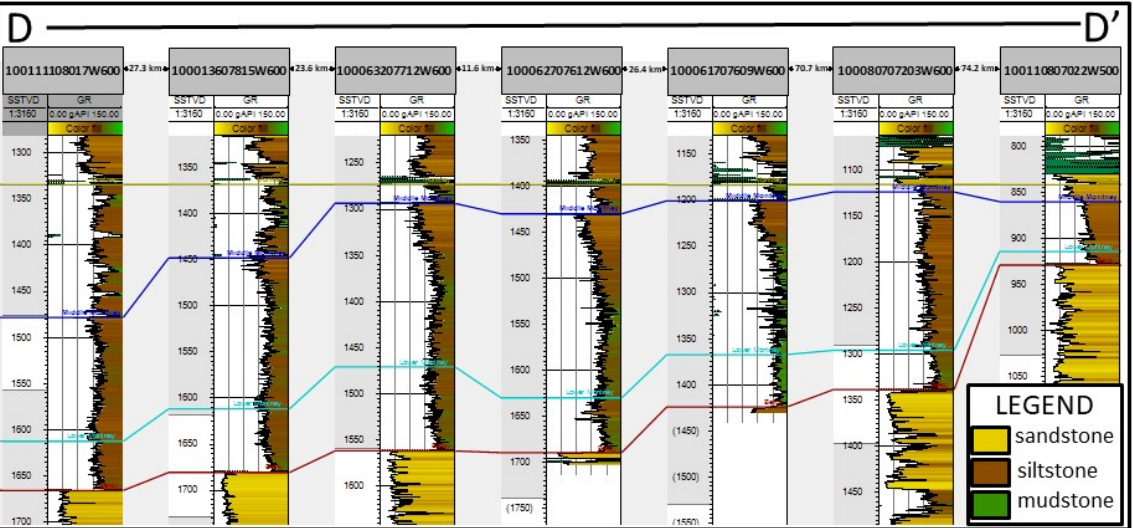
Figure 31. NW-SE cross-section along the depositional strike near the Dawson Creek area. See Figure 24 for the location of the cross-section D–D ′ . The Upper Montney is more organic rich and/or clay rich than the Middle and Lower Montney, as illustrated by the higher gamma ray values. The Upper Montney Top is the brownish yellow line, the Middle Montney Top is the dark blue line, the Lower Montney Top is light bluish green line, and the base of the Montney at the Belloy Top is the dark red line. The Montney Formation is thick (>250 m) across the majority of this cross-section as it is part of the Fort St. John graben area. The thickness dramatically reduces towards the SE as the cross-section exits the graben.